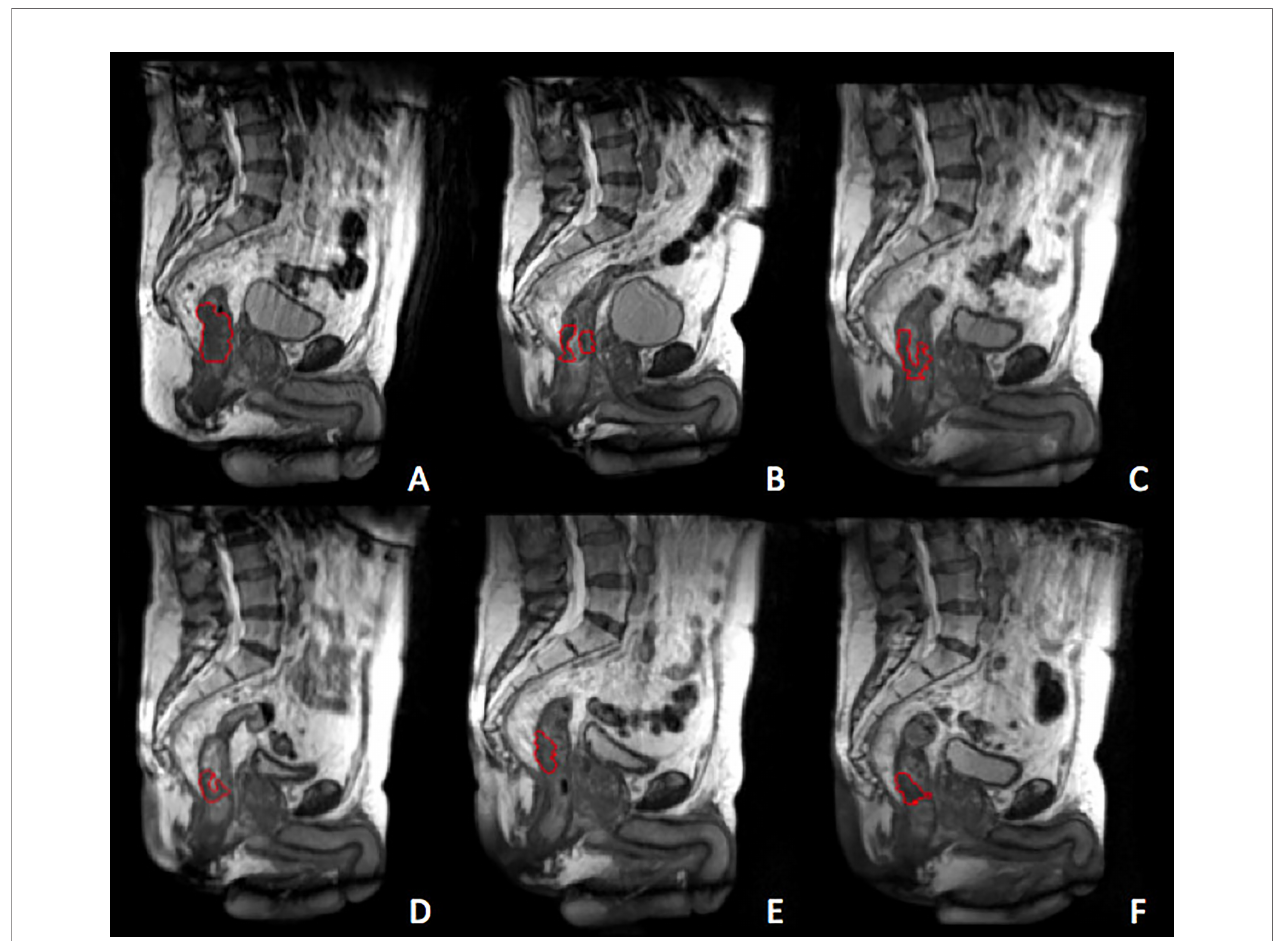
FIGURE 1 | Gross tumour volum (GTV) delineated at the treatment simulation (A) and at the different treatment fractions selected for the delta-radiomics analysis, corresponding to BED levels of 13 Gy (B) , 26 Gy (C) , 40 Gy (D) , 54 Gy (E) and 67 Gy (F) . The GTV is represented by the red